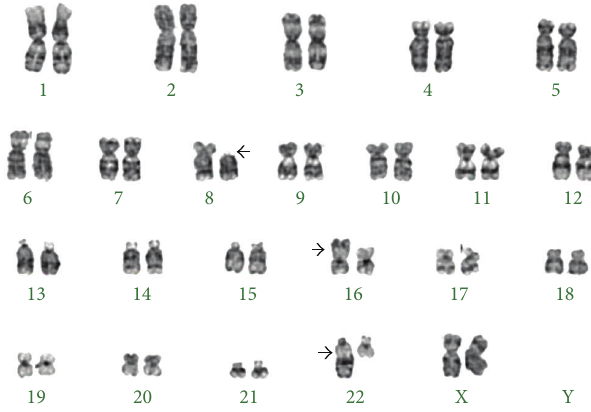
Figure 2: Conventional karyotype analysis of the bone marrow demonstrating t(8;16).